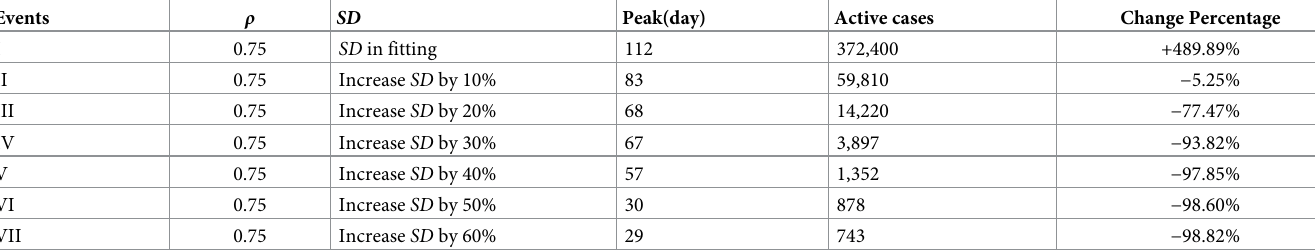
Table 13. Results of different scenarios Second Case, 3 rd scenario.